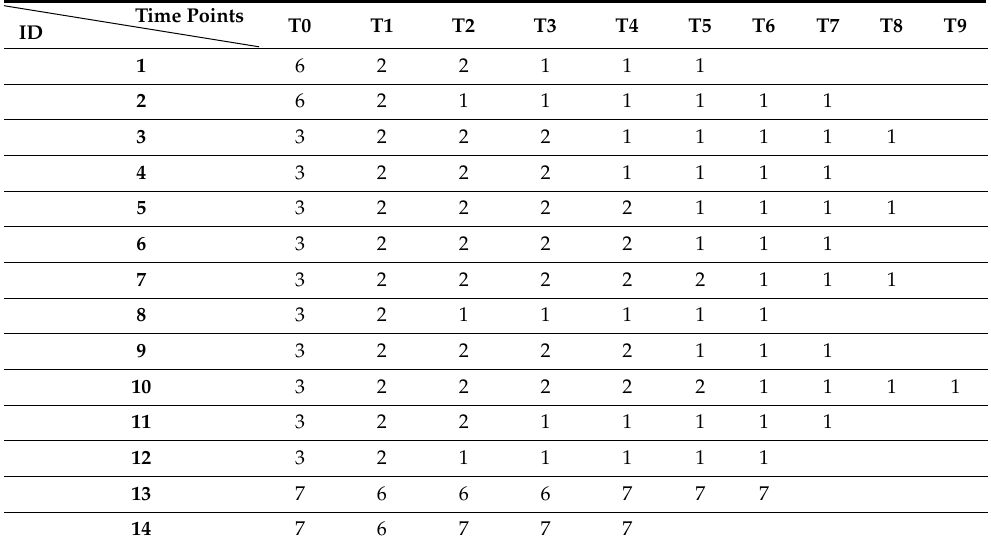
Table 5. Evolution of the SSS score in the study group over